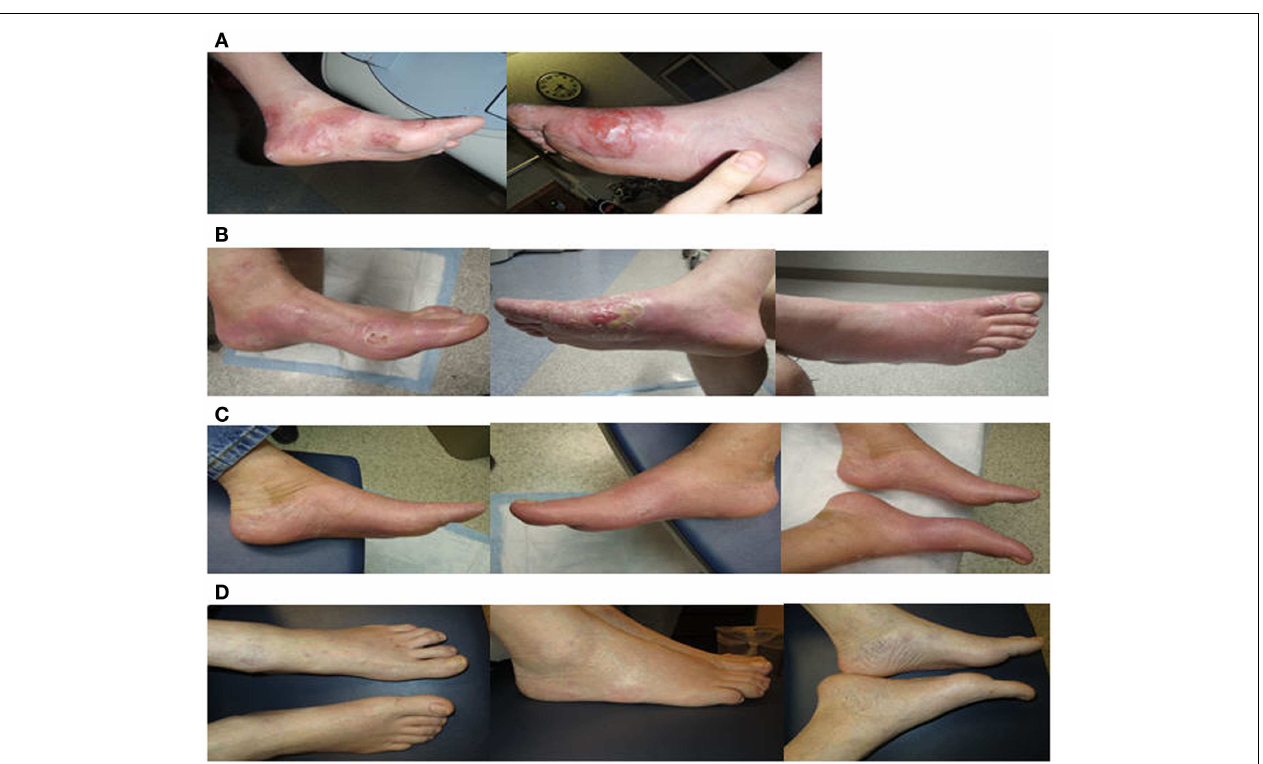
FIGURE 5 |A series of clinical photographs of patientA before treatment (A), immediately after treatment (B), 2months after treatment (C), and 12months after treatment (D) .